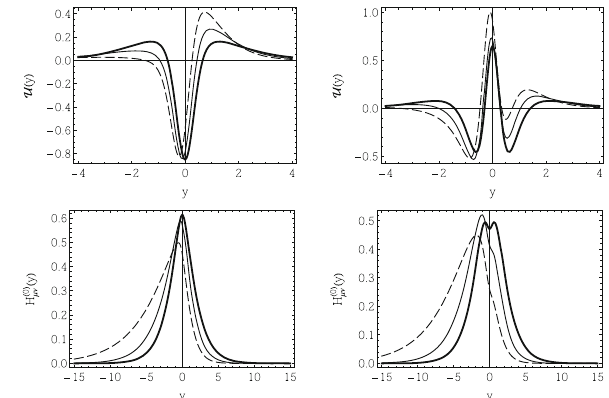
Fig. 24 Potential of stability (two top panel) and zero-mode (two bot- tom panel) obtain for the model of Sect. 3.4 with c = 0 , 0 . 2 , 0 . 4 and ψ = ϕ = 10 (two left panel) and ψ = − ϕ = − 10 (two right 0 0 0 0